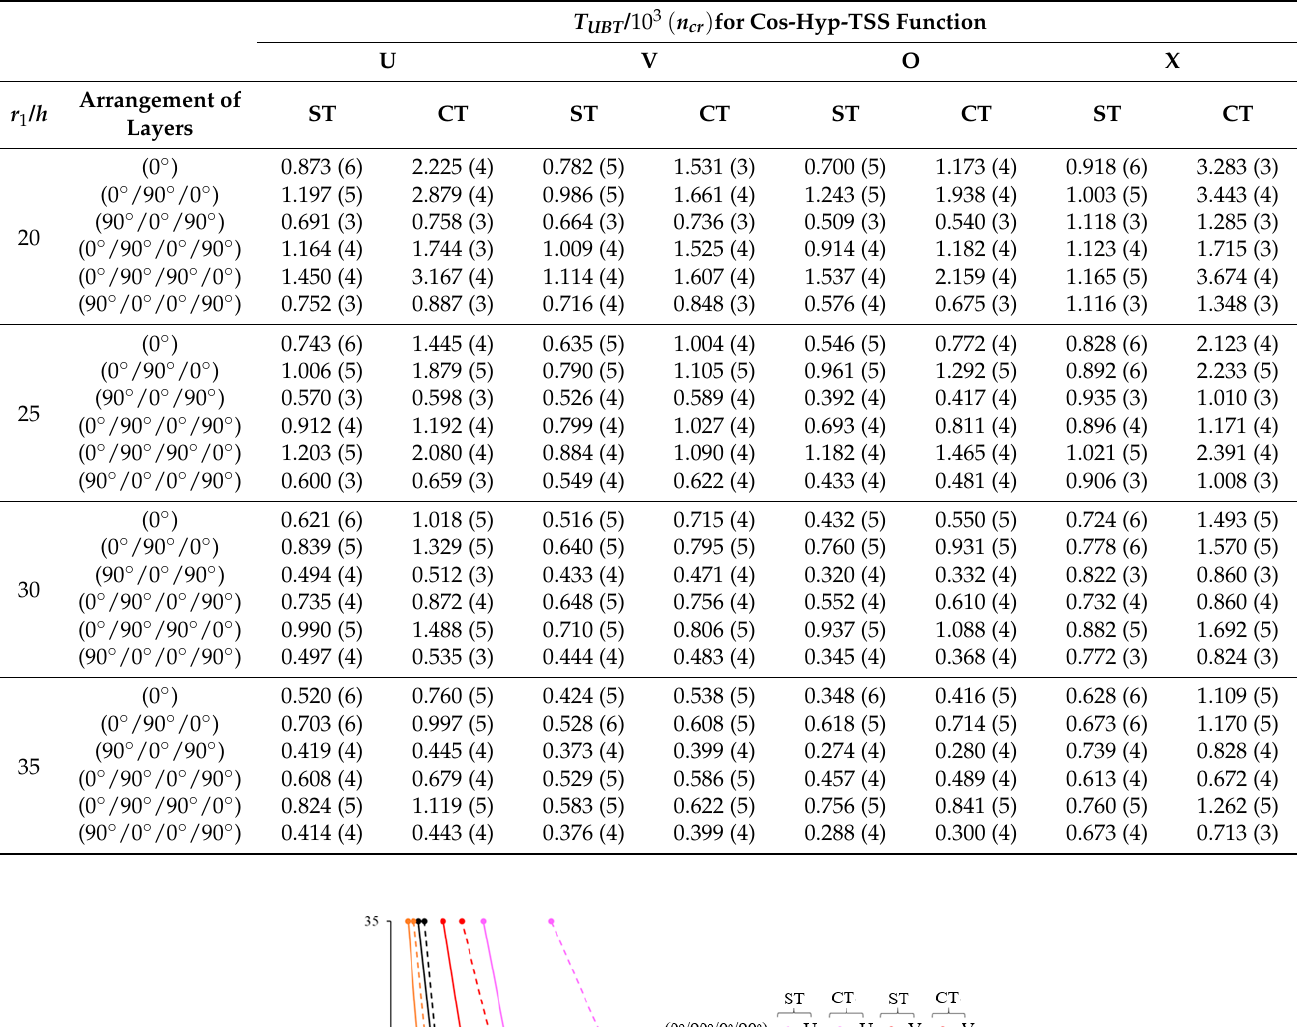
Table 5. Variations of UBT for single-layer and laminated cones with CNT-shaped layers for the Cos-Hyp-TSS function (within CT versus r 1 / h ).